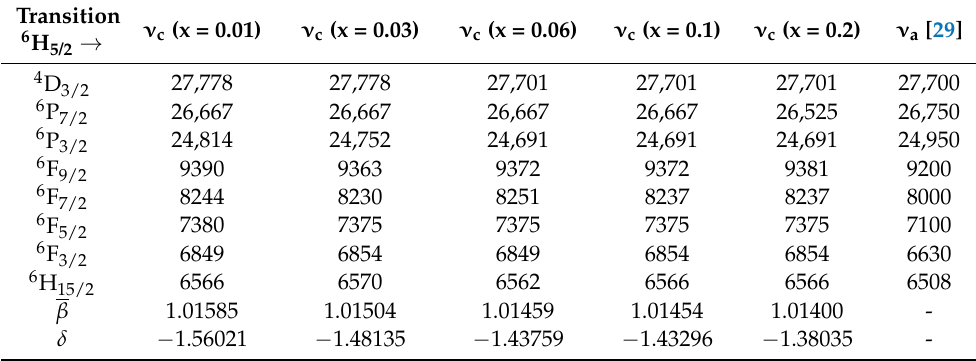
Table 2. Band positions of observed ν c and aqueous solution ν a (cm − 1 ), Nephelauxetic effect ( β ) and bonding parameters ( δ ) of Al 2 O 3 -(3-x)SrO: xSm 3+ (x = 0.01, 0.03, 0.06, 0.1, 0.2) glasses.